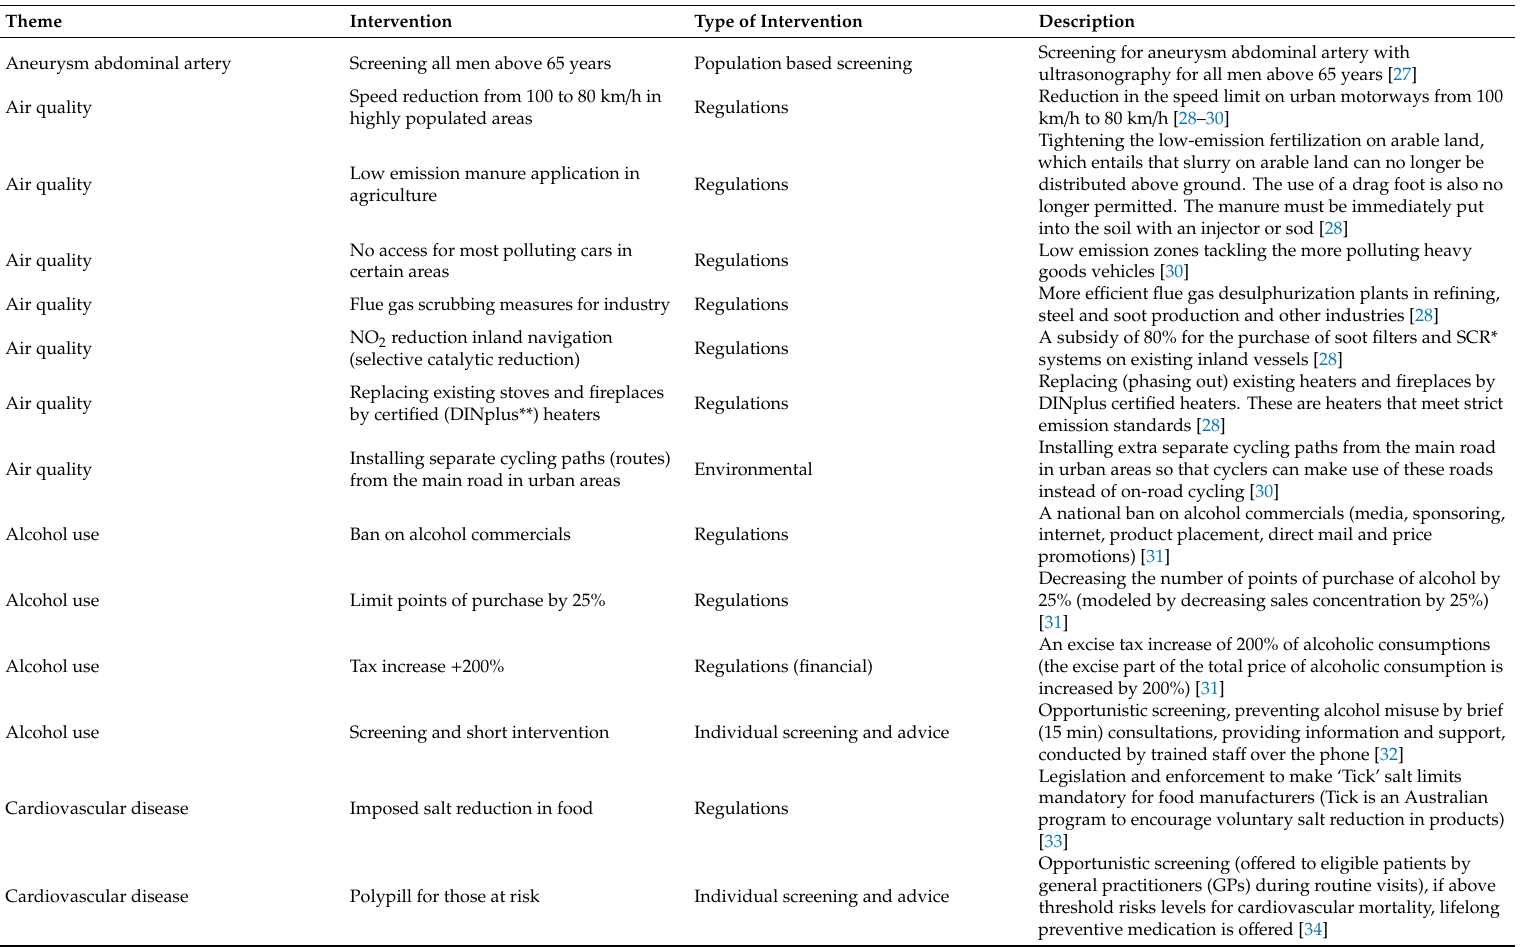
Table 1. Description of all 51 cost-e ff ective and cost saving